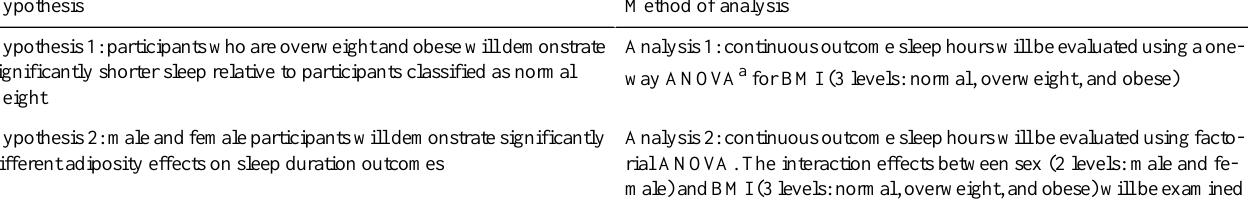
Method of analysisHypothesis Analysis 1: continuous outcome sleep hours will be evaluated using a